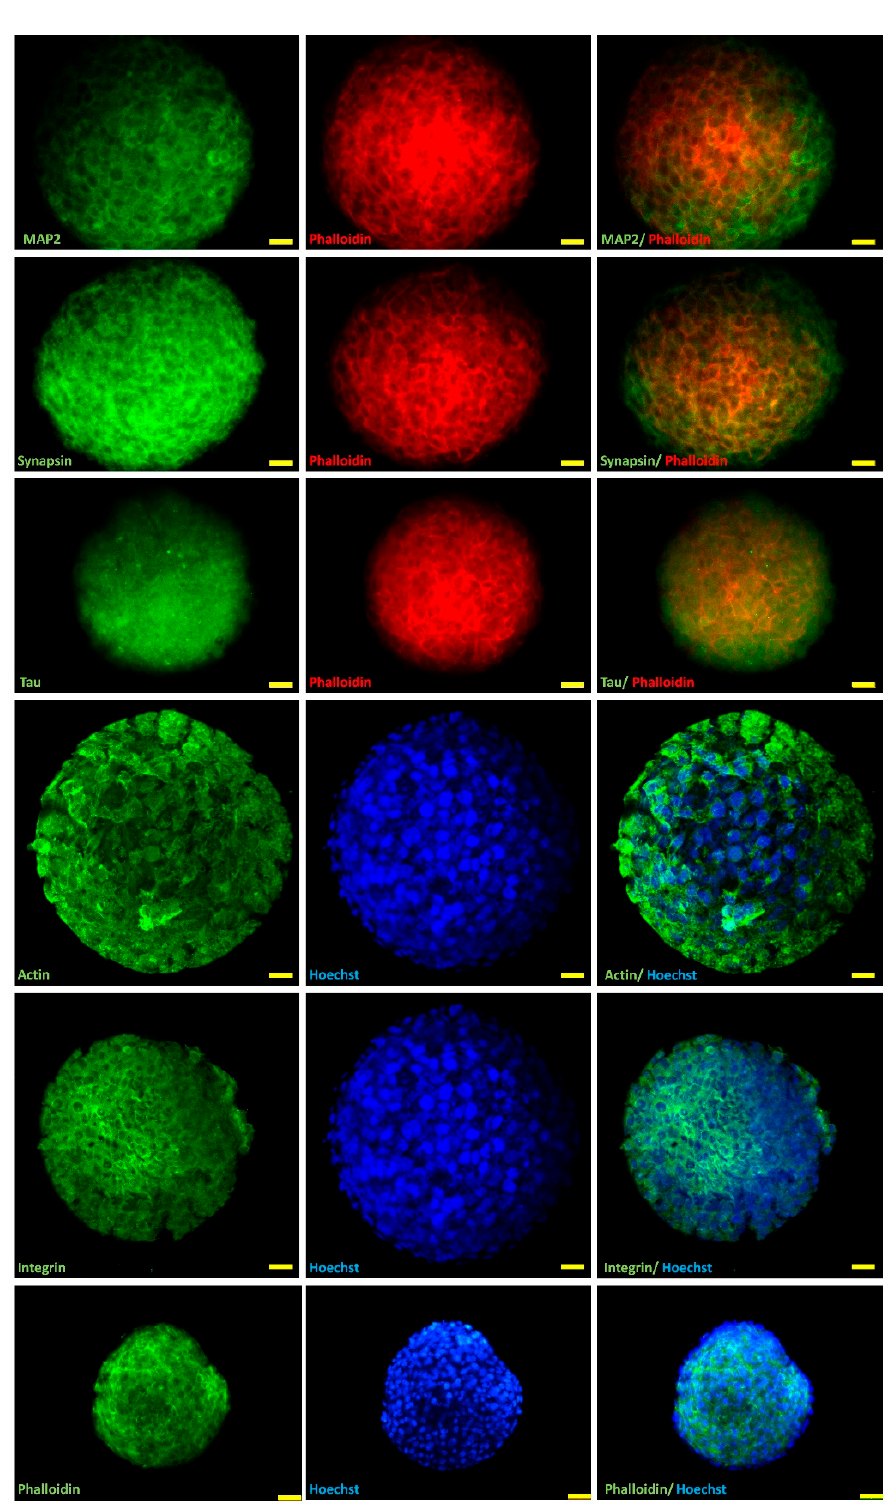
Synapsin expression indicates normal intercellular signaling, and integrin expression is a rough indicator of interactions with the extracellular matrix.